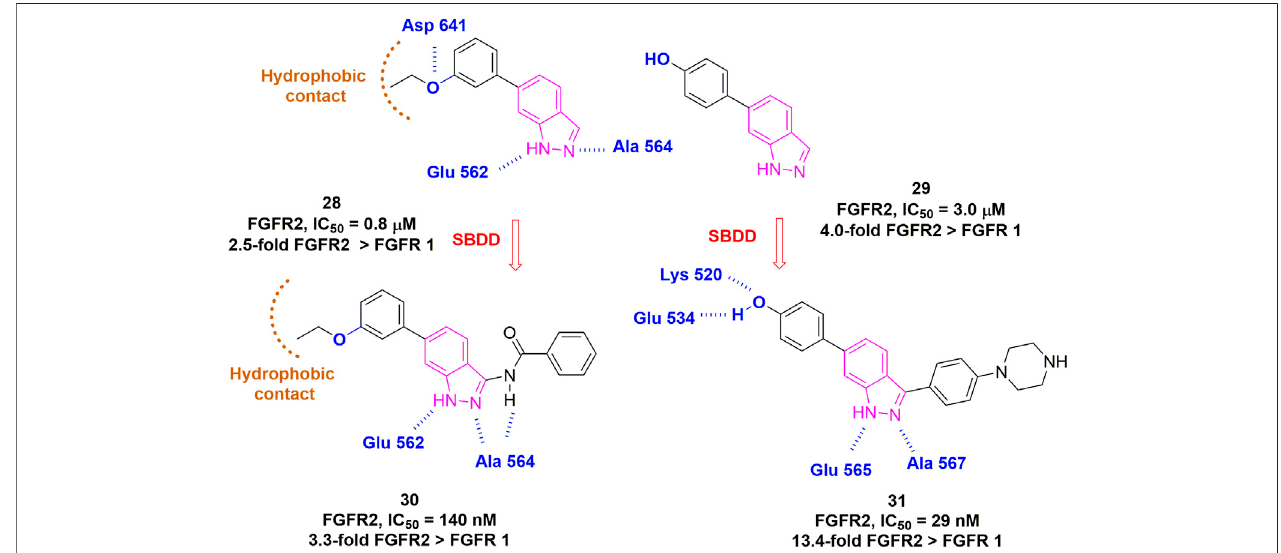
FIGURE 13 | Structure-guided approach for the development of selective FGFR2 inhibitors. H-bonds are outlined as blue hashed lines. Hydrophobic region is indicated by brown arc.